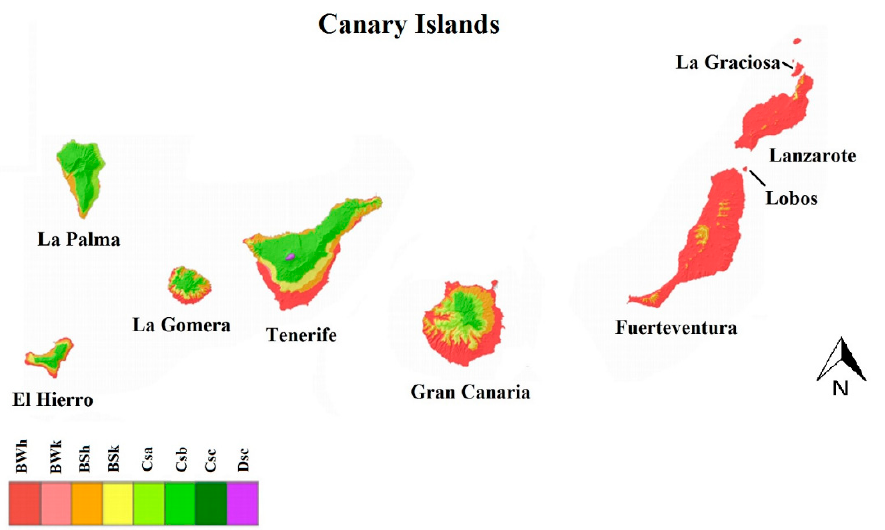
Figure 1. Köppen–Geiger climate classification of the Canary Islands, modified from State Meteor- ological Agency of Spain [26]. BWh (hot desert), BWk (cold desert), BSh (hot steppe), BSk (cold steppe), Csa (temperate with hot and dry summer), Csb (temperate with dry and warm summers), CSc (temperate with dry and cool summers), and DSc (cold without a dry season and a fresh sum- mer).